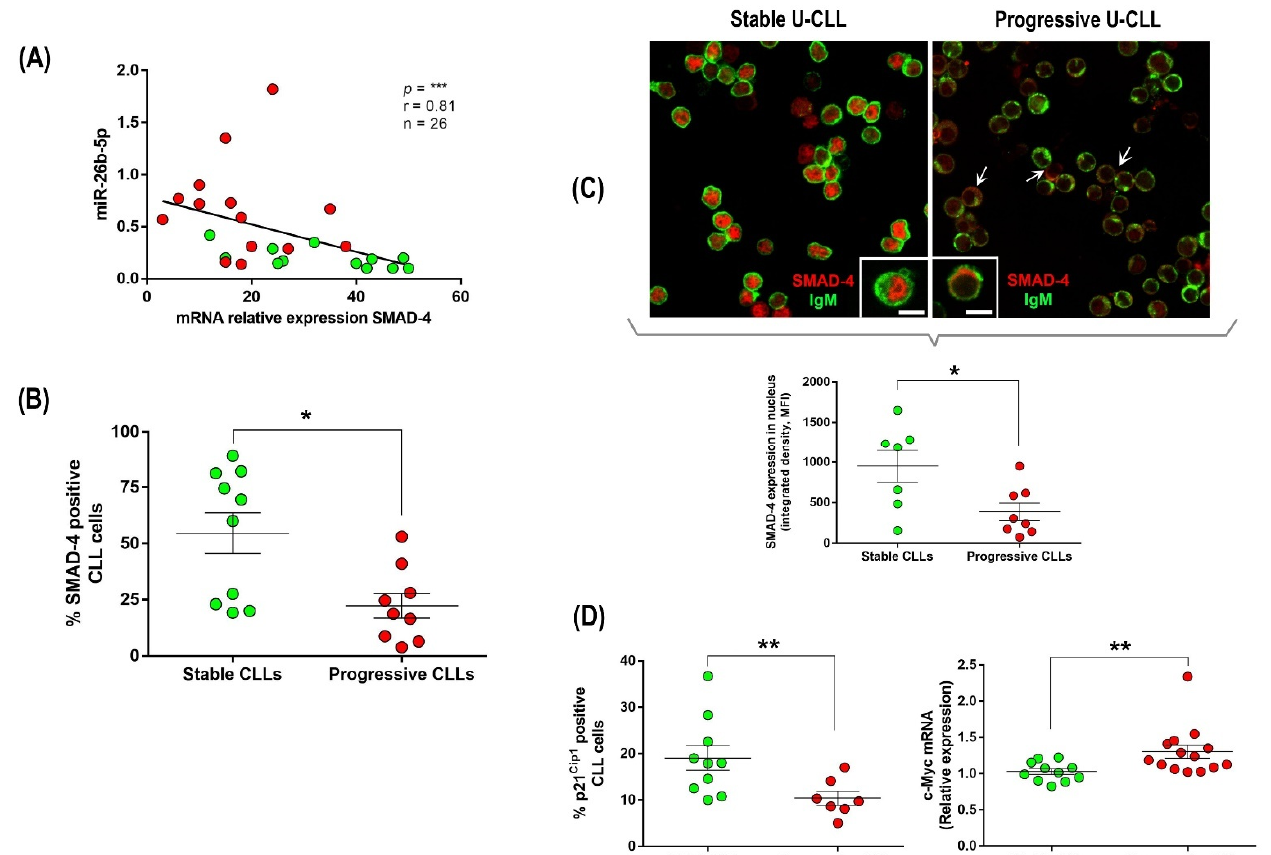
Figure 3. ( A – C ) Evaluation of mRNA and protein expression levels and cellular localization of SMAD-4 in CLL cells. ( A ) Correlation between miR-26b-5p and SMAD-4 mRNA expression in the U-CLL subgroups. Red circles = Progressive U-CLL, and green circles = Stable U-CLL ( p ≤ 0.0001, Spearman’s rank test, r = 0.81, n = 26). ( B ) SMAD-4 protein expression evaluated by flow cytometry in CLL cells (CD19+/CD5+) in the different U-CLL subgroups ( p = 0.013, Mann–Whitney Unpaired test, n = 19). ( C ) Confocal microscopy of Smad-4 (red) and IgM (green) from two representative patients; stable (CLL#10) and progressive (CLL#05) are depicted. Scale bar: 5 µ m. Specific fluorescence intensity in nucleus and cytoplasm was measured in the different subgroups. Between 100 and 200 cells were counted in each sample ( n = 15; stable U-CLLs, n = 7; and progressive U-CLLs, n = 8). Next, MFI in the nucleus and cytoplasm was used to obtain integrated density and compare mean fluorescence intensities of Smad-4 in the nuclei of CLL samples, ( p = 0.040, Mann–Whitney Unpaired test, n = 15). ( D ) p21 − Cip1 protein expression evaluated by flow cytometry gating CD19+/CD5+ cells and c-MYC mRNA relative expression from stable and progressive U-CLLs ( p = 0.007, n = 17 and p = 0.004, n = 25, respectively, Mann–Whitney Unpaired test) are depicted. In all cases, p < 0.05 was considered statistically significant, (* = p < 0.05, ** = p < 0.01, and *** = p < 0.001, ns = not